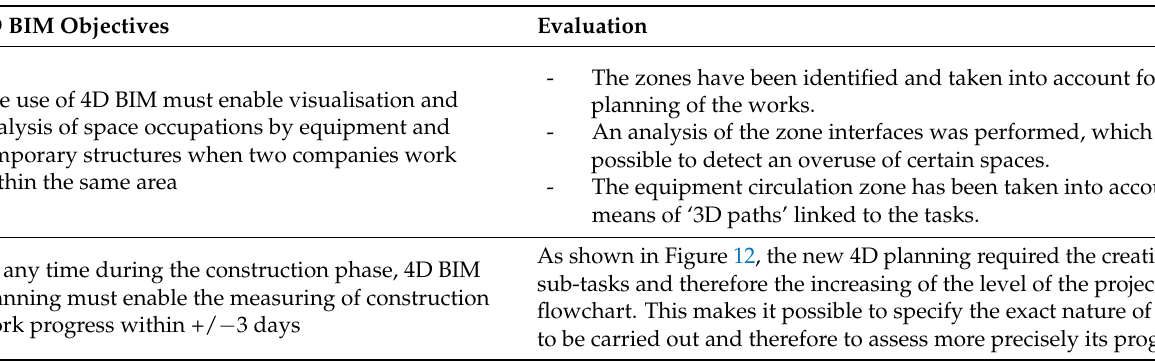
Table 4. Proposed method evaluation regarding the client’s 4D BIM objectives